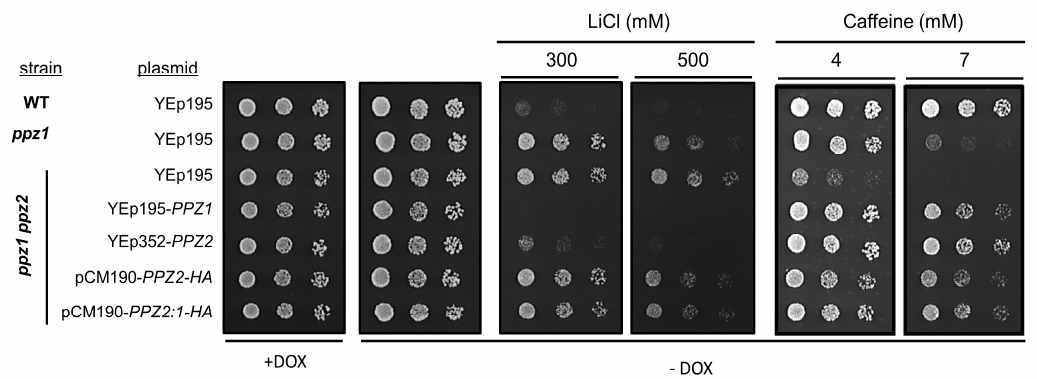
Figure 4. Effect of Ppz2 and Ppz2:1 expression in the lithium-tolerant and caffeine-sensitive phenotype of Ppz-deficient cells. Wild type BY4741 (WT), ppz1 Δ and AGS19 strains were transformed with the indicated plasmids and spotted, as in Figure 2A, on plates containing the indicated amounts of LiCl or caffeine. Plates were incubated for 3 days and pictures taken. Clones used for PPZ2-HA and PPZ2:1-HA were 1 and 5, respectively.